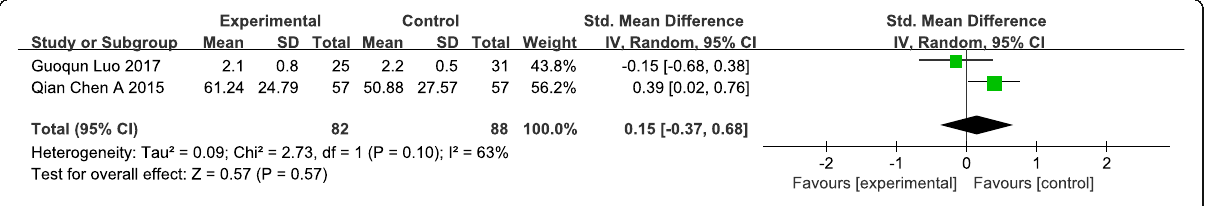
Fig. 9 Forest plot of the high-quality embryo rate.